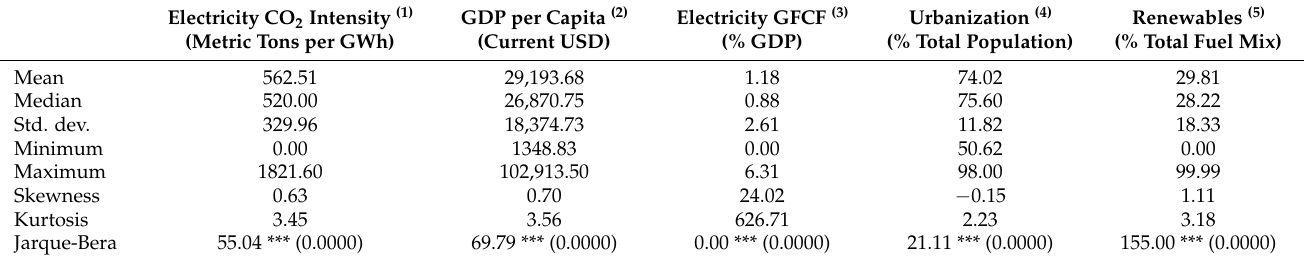
Table 1. Descriptive statistics of total panel (Years: 1995–2018).